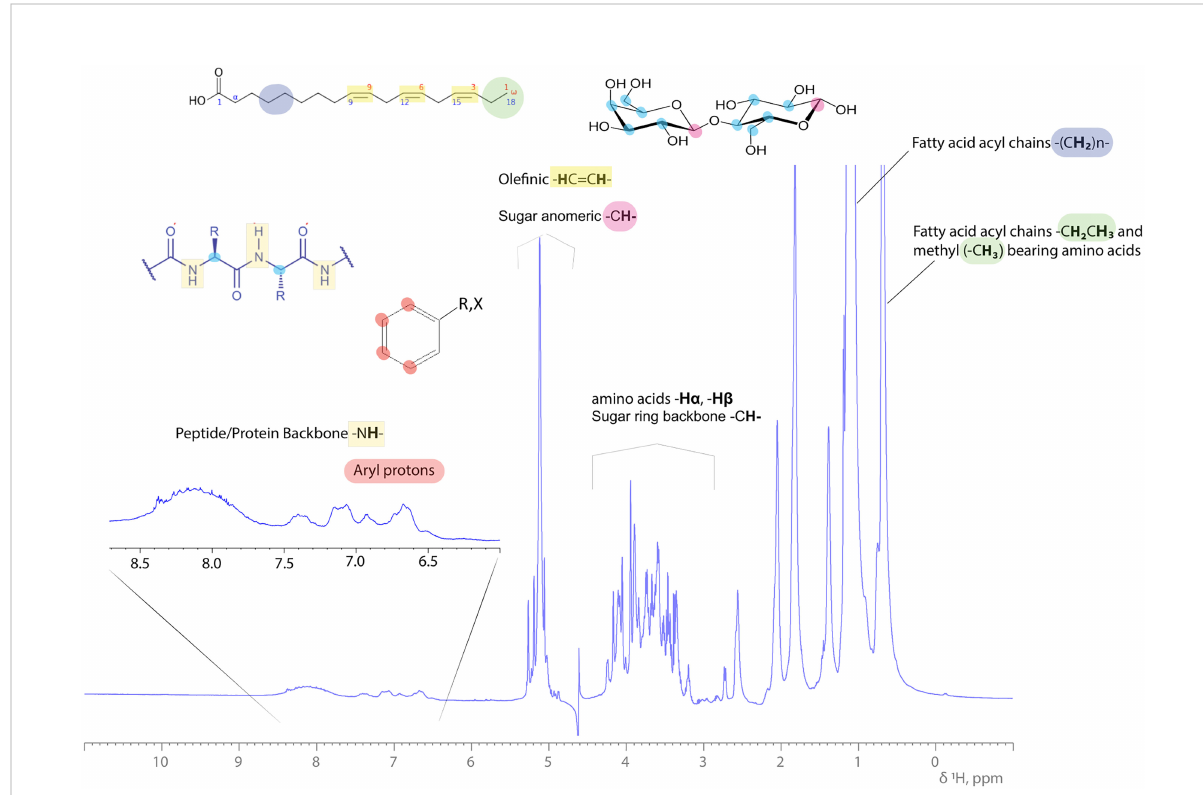
FIGURE 1 1H 1D NMR spectrum of a complex bioemulsi fi er extract in an aqueous (H2O:D2O, 90:10%) solution. Characteristic resonances are annotated across the 1H ppm scale, indicating the protein/peptide backbone amide protons, saccharide (sugar ring) and ole fi nic (double bonds in fatty acid aliphatic chain) protons, amino acid side chain protons (H a , H b and -CH3) and FAs ’ methylene and methyl protons arising up fi eld. Examples of structural blocks are depicted and highlighted along with their indicative 1H